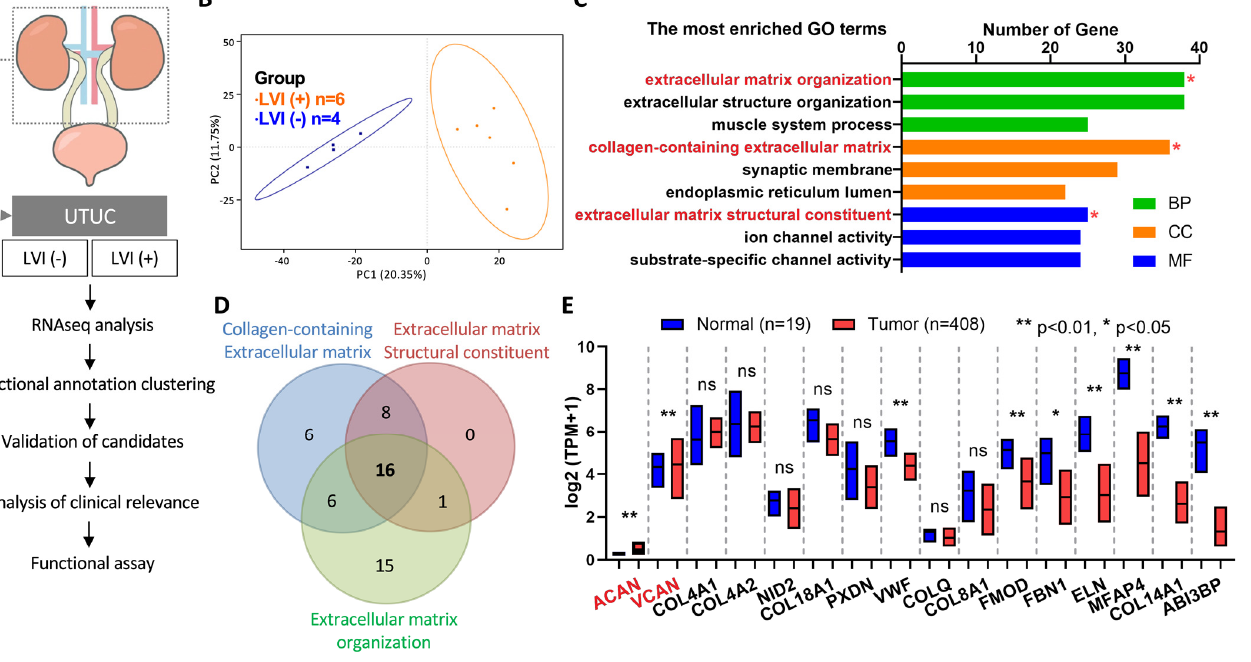
Figure 1. VCAN as a potential oncogene in lymphovascular invasion of UTUC through RNAseq analysis. ( A , B ) The flowchart illustrates the process of comparing the RNA profiles of normal and UTUC tumors, specifically examining the RNA expression in UTUC tumor tissues from patients with or without lymphovascular invasion. ( C , D ) The results of the RNA analysis were further evaluated using Gene Ontology (GO) analysis to classify the differentially expressed genes based on their molecular function, biological process and cellular component. Red asterisk, functional clustering was performed using these features. ( E ) Statistical analysis of the gene expression levels in normal and bladder cancer samples was conducted to identify genes with significant differences in expression. ns, not significant; * p < 0.05; ** p < 0.01.